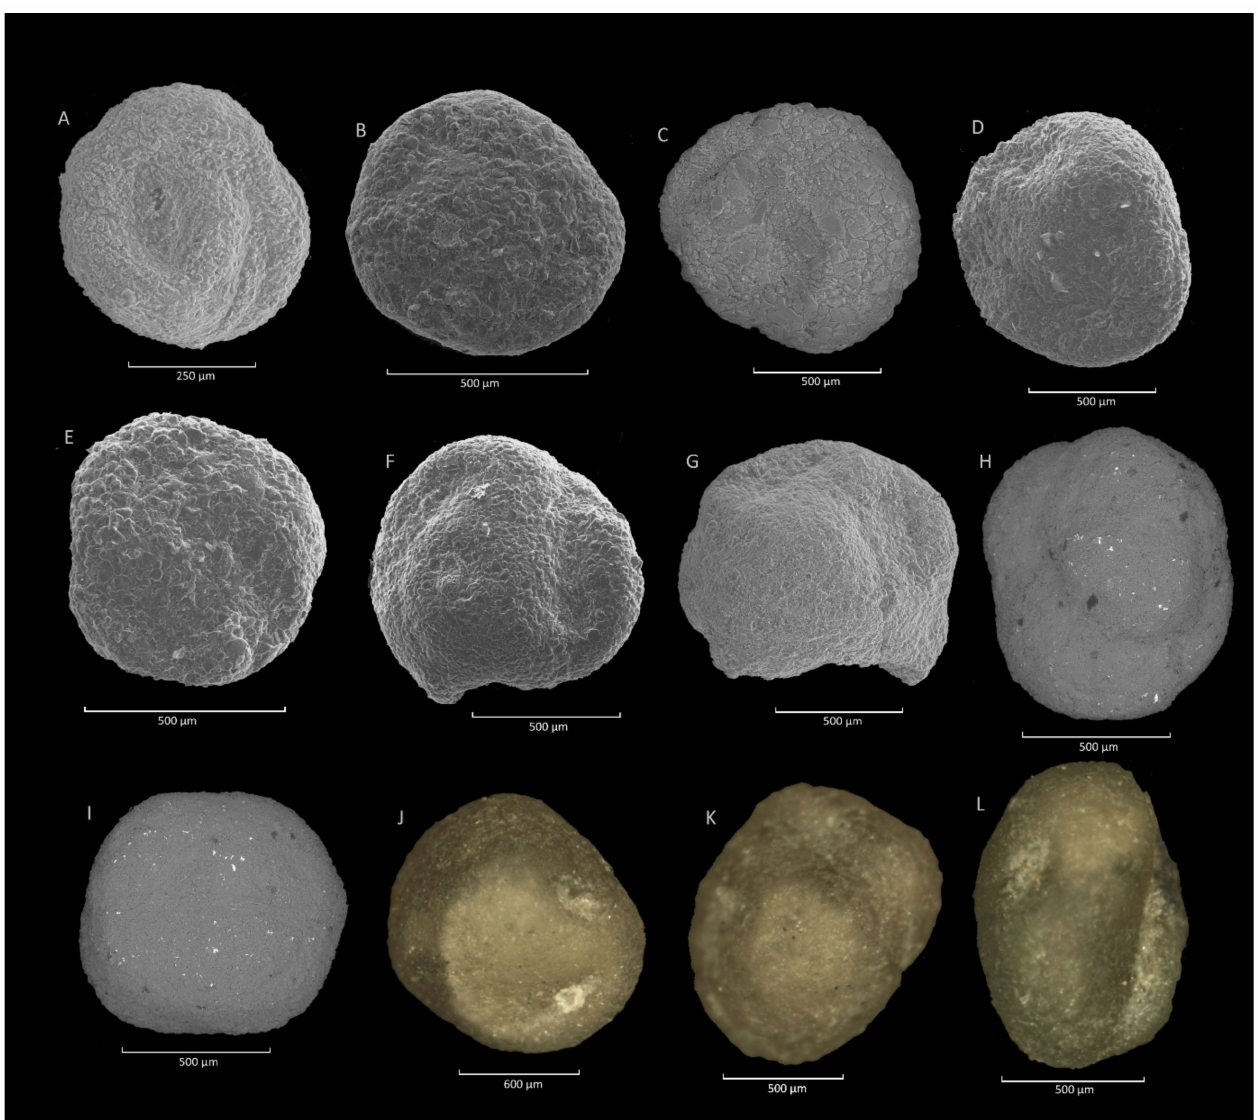
Figure 22. Praesphaerammina subgaleata (Vaš í ˇcek). ( A , G ): Jezioro Ro˙znowskie section; ( B ): Stradomka section; ( C – F ): Krzesławice section; ( H , I ): Mosorny section; ( I – L ): Klimk ó wka